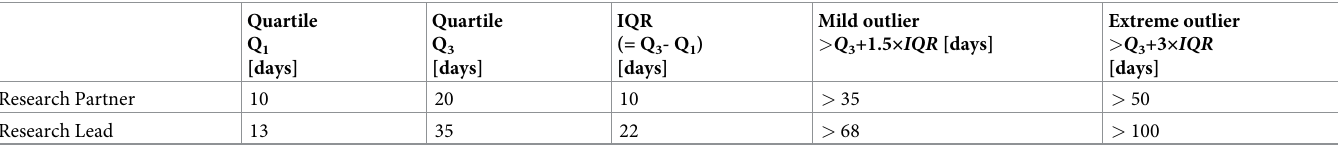
Table 2. Outlier